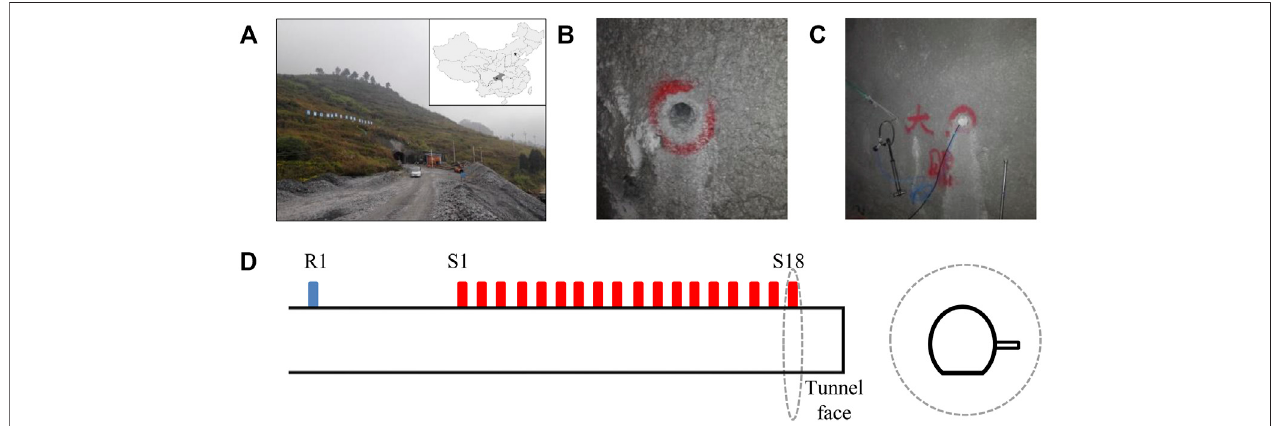
FIGURE 10 | Layout of seimic observation system in Maanshan tunnel. (A) is the tunnel location. (B) is the layout of the blasthole. (C) is the position of the geophone. (D) is the schematic diagram of the observation system, and inside the dotted line is a cross section of the tunnel.